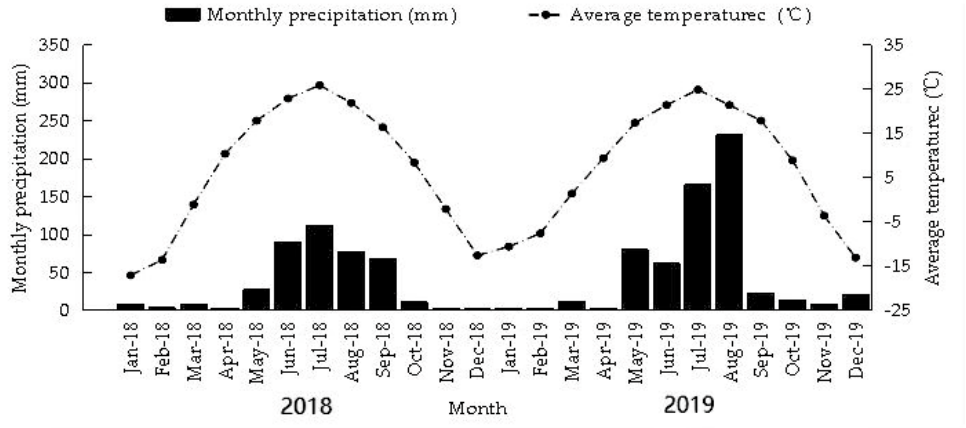
Figure 1. Average temperature and precipitation from May to October 2018 and 2019.